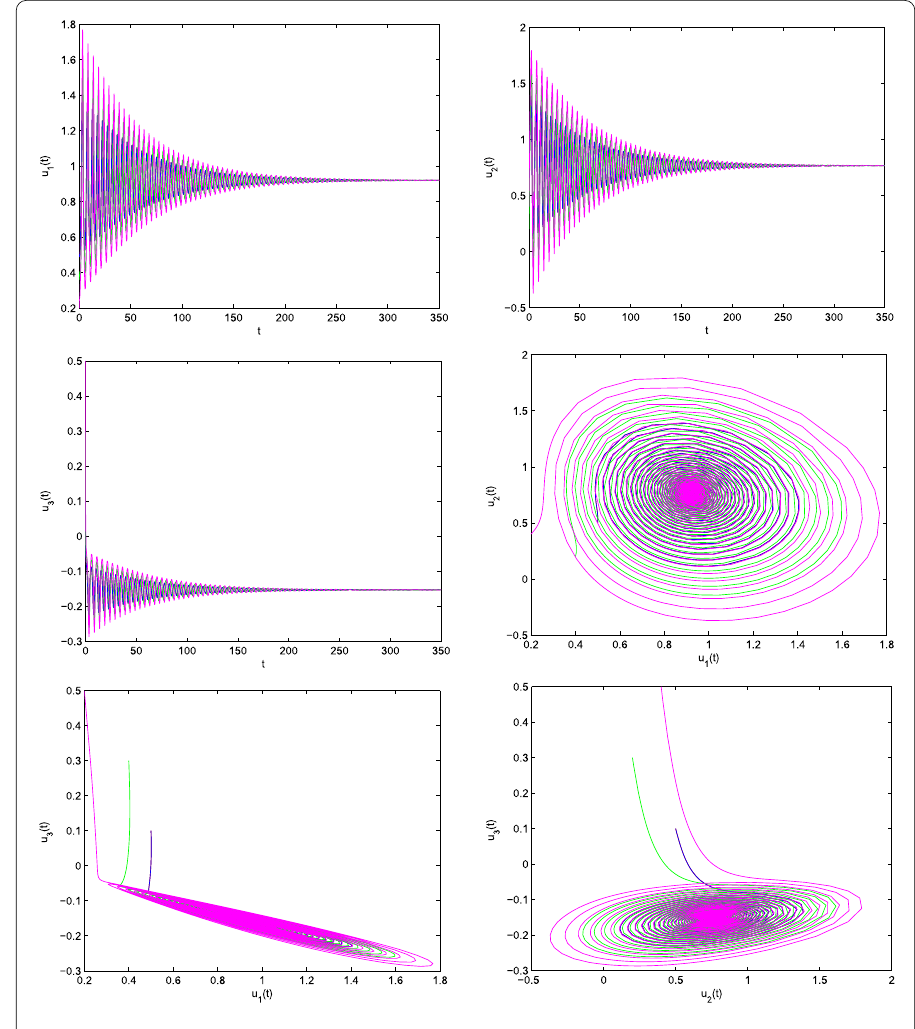
Figure 1 Dynamics of (4.1) with ς = 0.09 < ς 0 ≈ 0.1 and the initial value